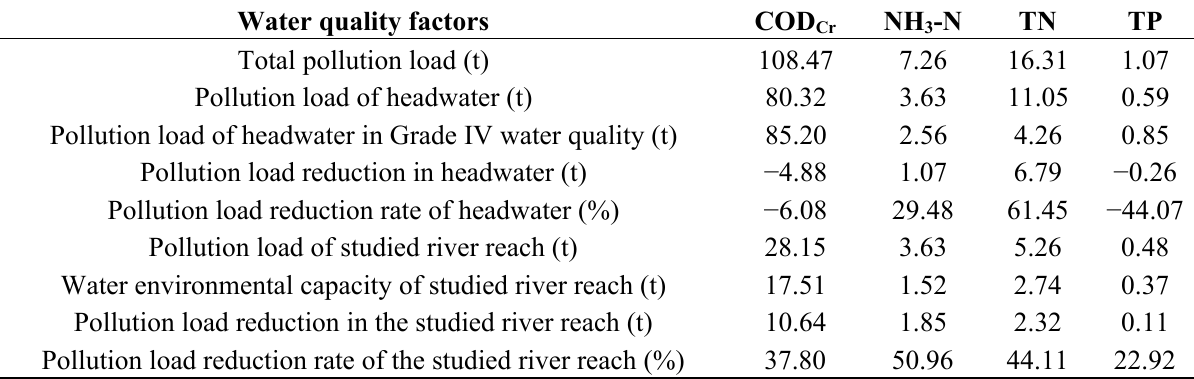
Table 9. Pollution load reduction in Hongqi